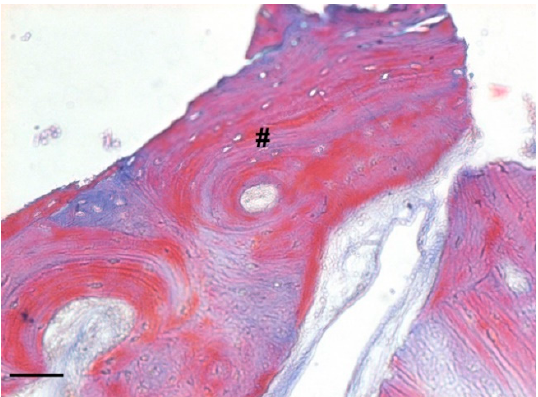
Figure 17. Detail of the bone sample stained with Masson’s trichrome staining solution (magnification 100×, scale bar 100 µm). The image shows the presence of lamellar bone indicating the complete bone remodeling (#).